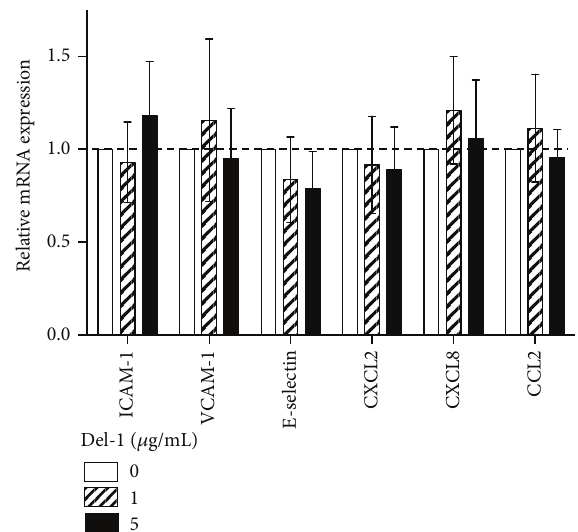
Figure 2: Effect of Del-1 treatment on human endothelial cell expression of adhesion molecules and chemokines. HUVEC were treated with the indicated concentrations of human Del-1 and were assessed for mRNA expression of the indicated cell adhesion and chemokine molecules by quantitative real-time PCR; results were normalized against GAPDH mRNA and expressed as fold change relative to untreated controls, which were assigned an average value of 1. Data are means ± SD ( 𝑛 = 5 sets of endothelial cells). No statistically significant differences were detected between Del-1 treatments and untreated